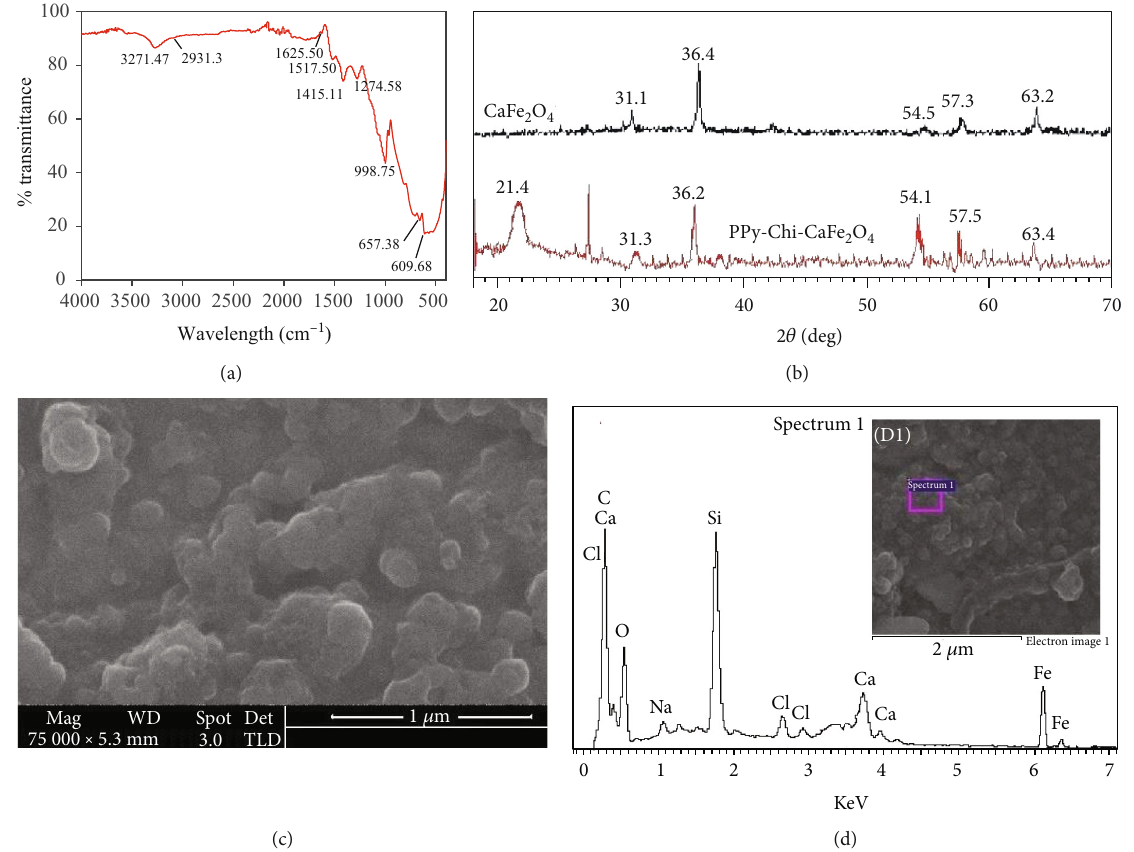
Figure 2: (a) The FT-IR spectrum, (b) the XRD spectrum, (c) the HR-TEM image, and (d) the EDX analysis of the PPy-Chi-CaFe sensing